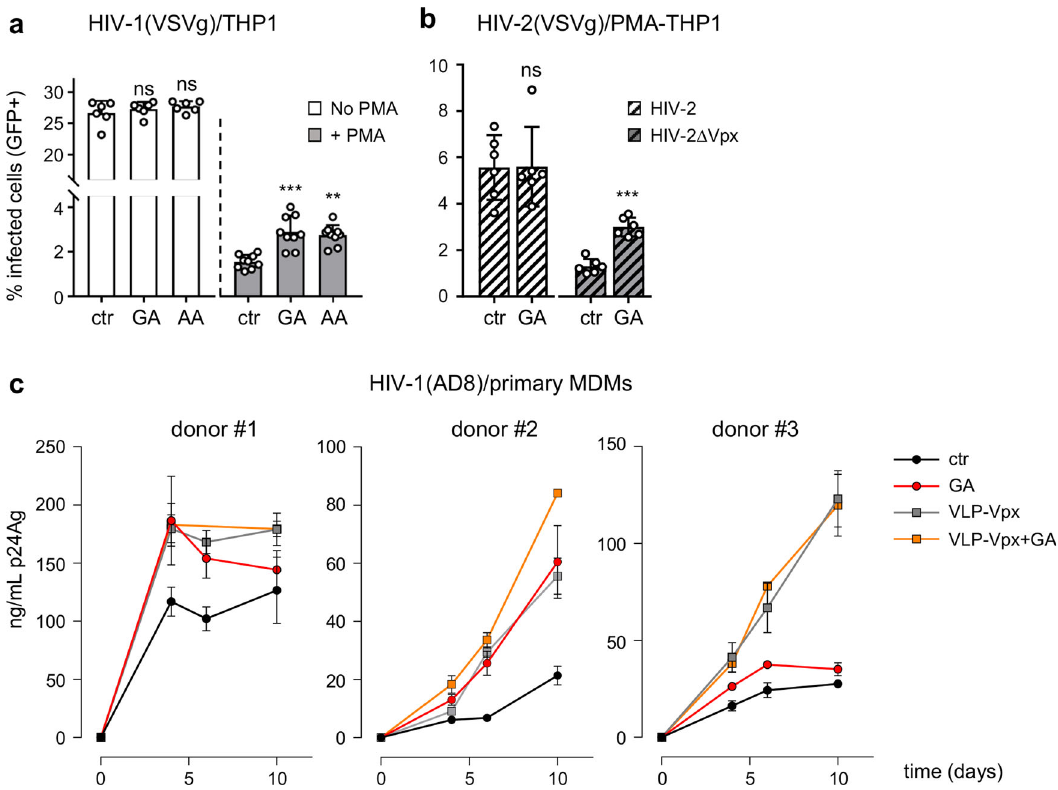
Fig. 6 Infectivity of SAMHD1-sensitive viruses is enhanced by inhibition of SUMOylation in macrophages. a THP1 cells were differentiated into macrophage-like cells by incubation with PMA (100 ng/mL, 24 h), or left untreated. Twenty-four hours later SUMOylation was inhibited by exposure to gingkolic acid (GA, 50 µ M) or anacardic acid (AA, 50 µ M) for 2 h before challenge with VSVg-pseudotyped HIV-1 (moi = 0.2), b HIV-2 or HIV-2 Δ Vpx (moi = 0.3) viruses harboring the EGFP reporter gene. The percentage of infected (GFP-positive) cells was measured by fl ow cytometry after 48 h. Data (mean ± SD) from one representative experiment performed in three technical replicates are shown ( n ≥ 2). Statistical signi fi cance was assessed by two- way-ANOVA test with a Dunnett ’ s multiple comparison post-test. ** p < 0.01; *** p < 0.001; ns not signi fi cant, p > 0.05. c Human MDMs generated from healthy donors (same as Fig. 1d) were incubated with VLP harboring Vpx, or not, for 24 h and then exposed to GA or vehicle (DMSO, 2 h) before challenge with the AD8 HIV-1 strain (50 ng/mL p24Ag). Viral replication was monitored overtime by measuring the p24 antigen (p24Ag) released in the cell culture